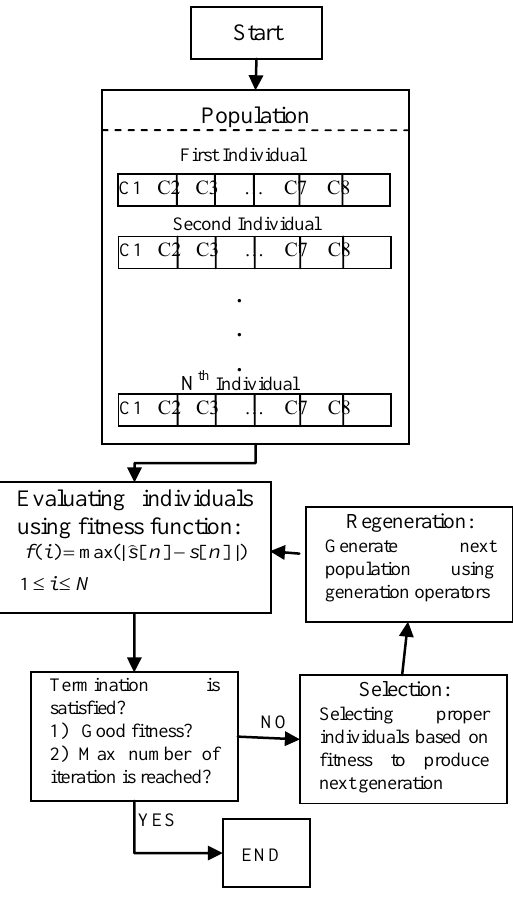
Figure 5. Diagram of the proposed method.